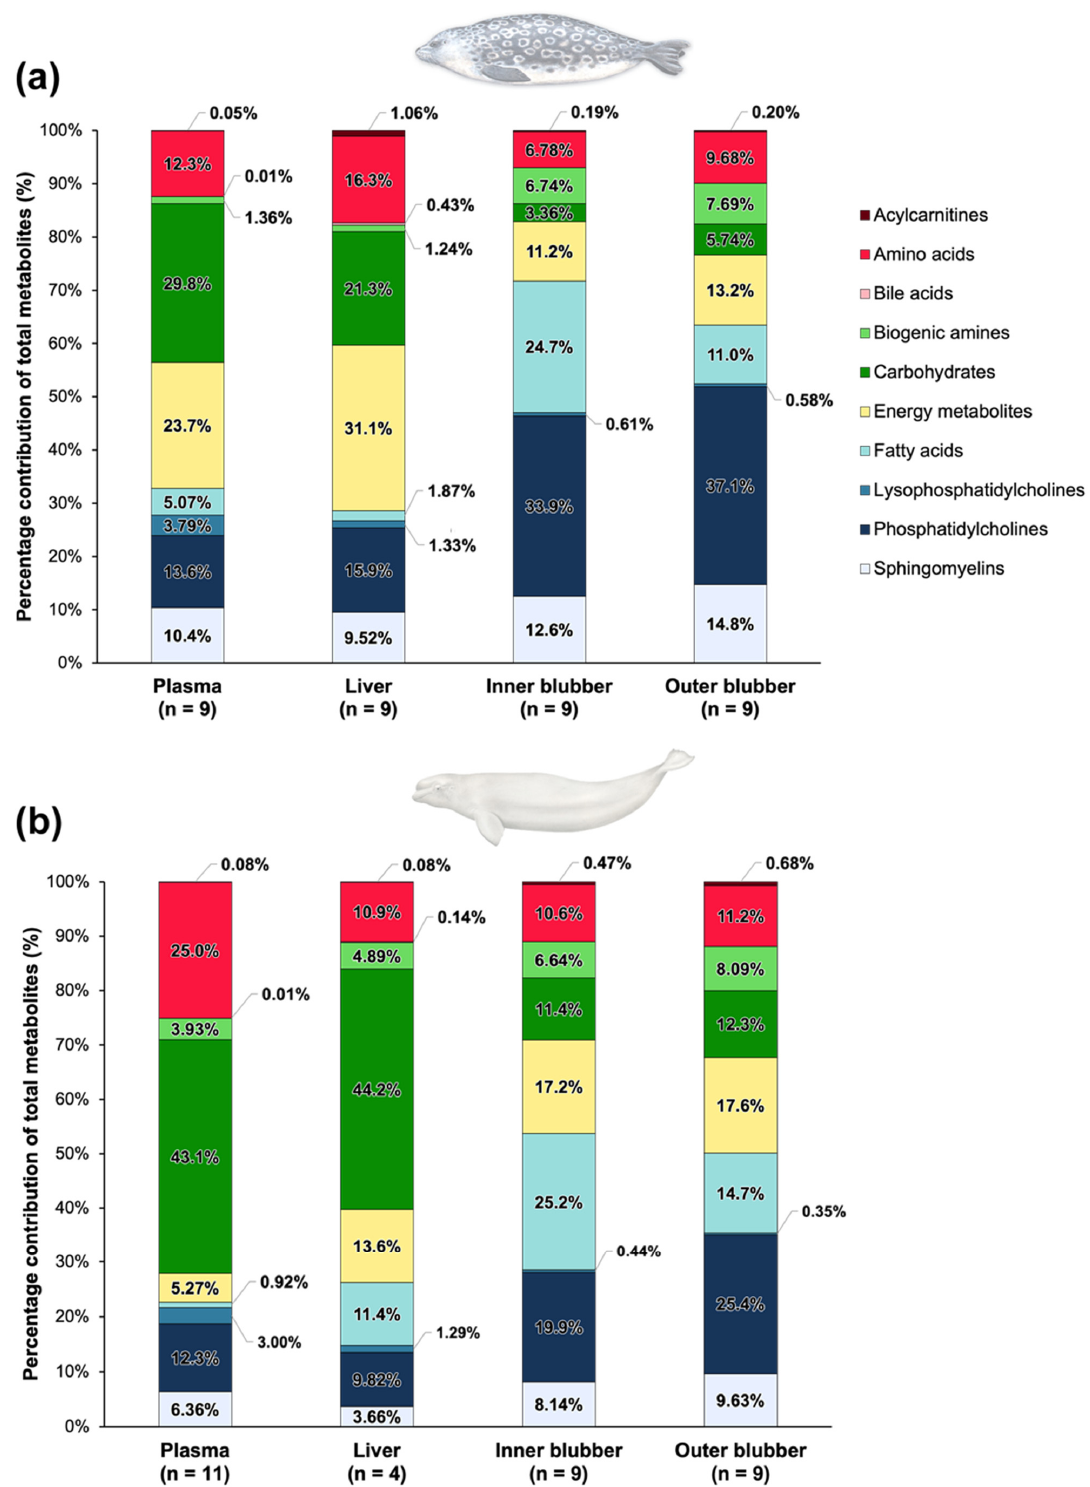
Figure 2. Inner and outer blubber had a greater proportion of lipid classes (i.e., sum of acylcarnitines, fatty acids, lysophosphatidylcholines, phosphatidylcholines and sphingomyelins) relative to plasma and liver. Average percent contribution of metabolite classes in plasma, liver, inner blubber and outer blubber of male adult seals ( n = 9) from Lake Melville ( a ) and Eastern Beaufort Sea belugas ( n = 13) ( b ). The plasma metabolite profiles of two belugas sampled in 2009 were considered outliers and therefore were not